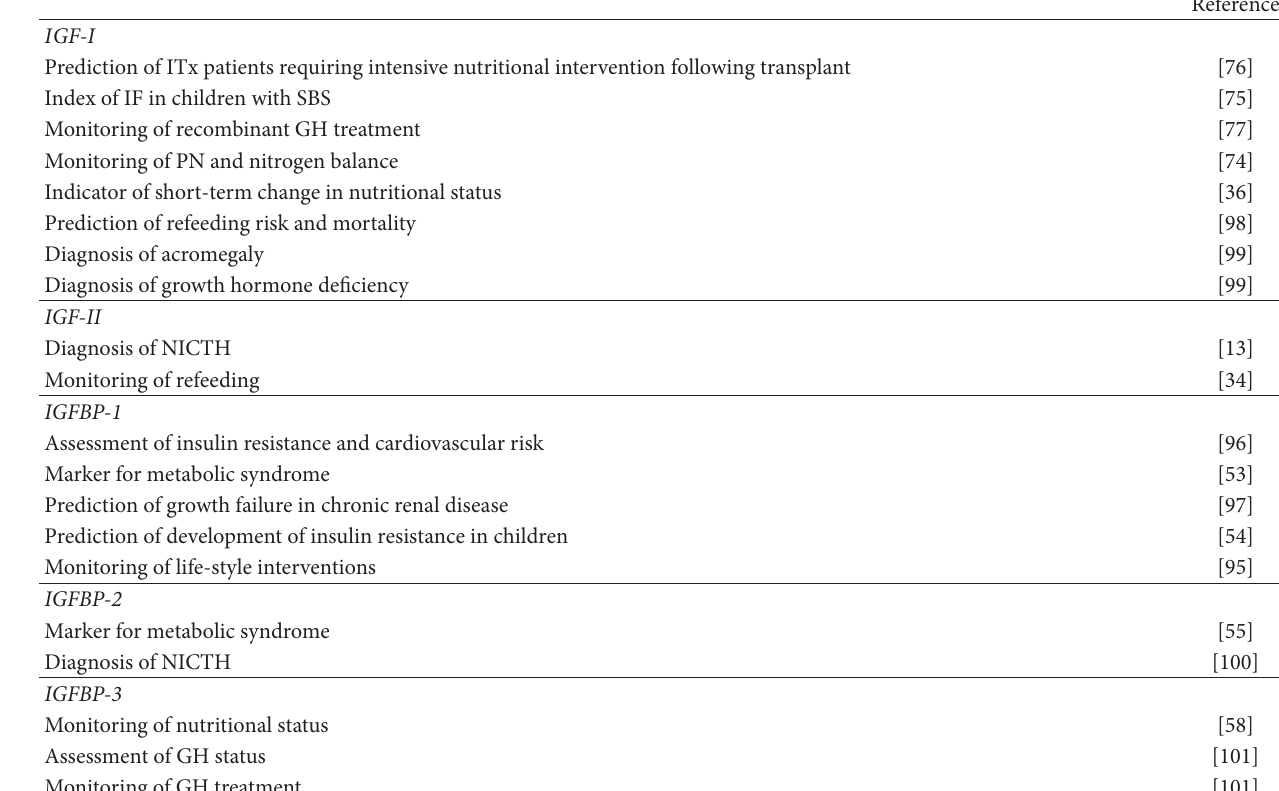
T 4: Possible clinical utility for measurement of serum IGF axis